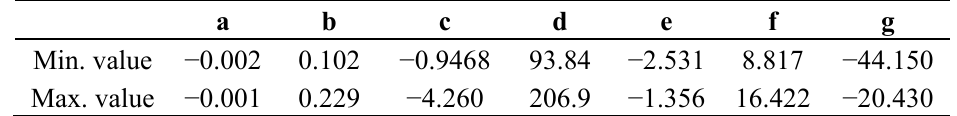
Table 4. Min. and Max. values for percentage of lost packets.